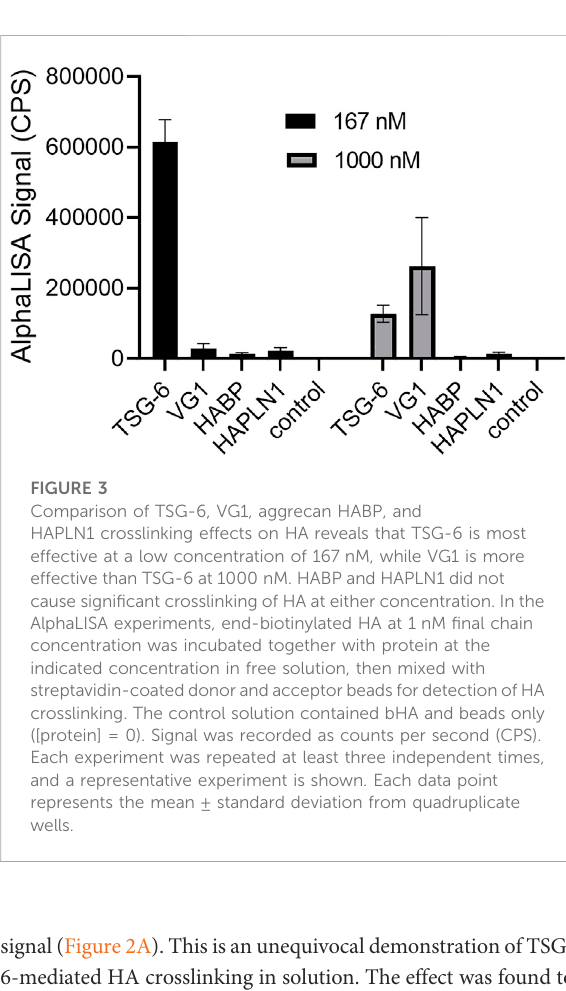
from quadruplicate wells.